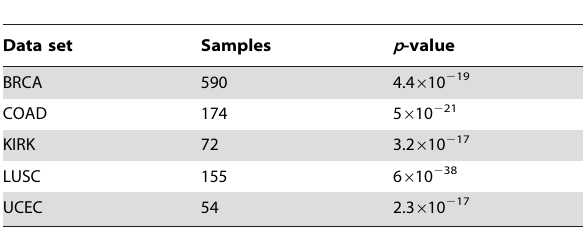
Table 1. Number of samples in each data set. Samples